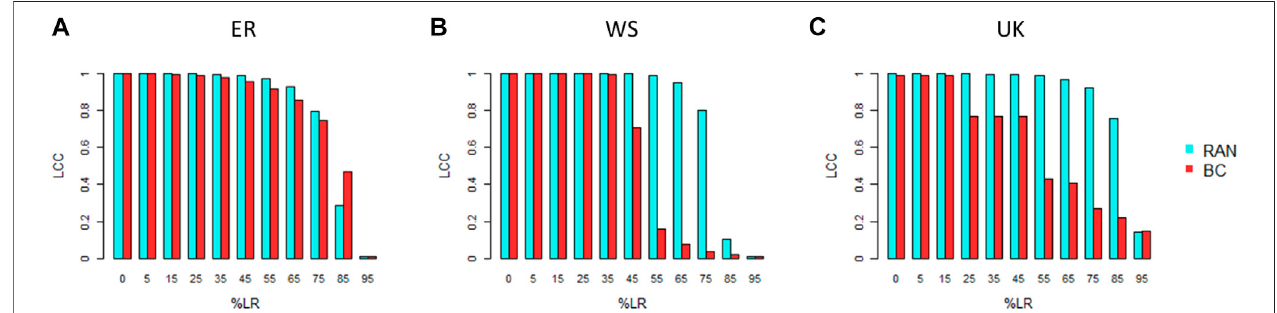
FIGURE1| Staticepidemicspreadingindicatorslargestconnectedcomponent(LCC)asafunctionofthefractionofthelinksremoved(%LR)forthethreenetworks analyzed. Blue bars indicate the LCC subjected to random link removal (RAN), whereas red bars indicate the LCC under link betweenness centrality removal (BC). The